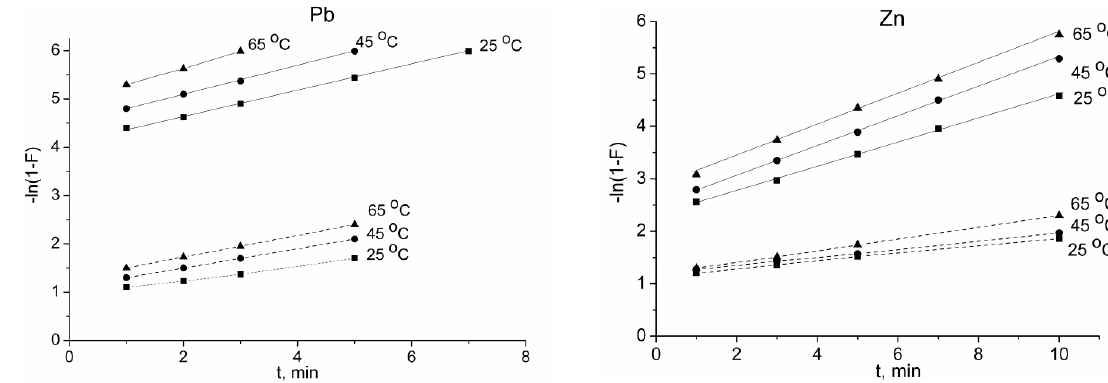
Figure 9. Film di ff usion kinetics plots for The lead and zinc sorption on titanium phosphate. The initial Figure 9. Film diffusion kinetics plots for the lead and zinc sorption on titanium phosphate. The initial concentrations of Pb 2 + and Zn 2 + ions were 1 mmol · L − 1 (solid line) and 10 mmol · L − 1 (dashed concentrations of Pb 2+ and Zn 2+ ions were 1 mmol·L −1 (solid line) and 10 mmol·L −1 (dashed line).